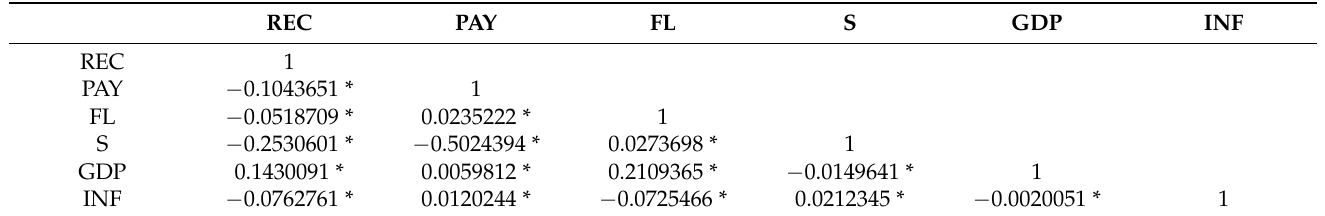
Table 3. Correlation